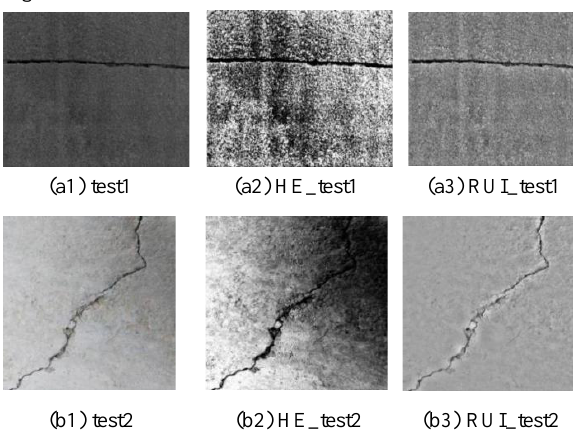
Figure 1. Results of the histogram equalization and remove uneven illumination algorithm